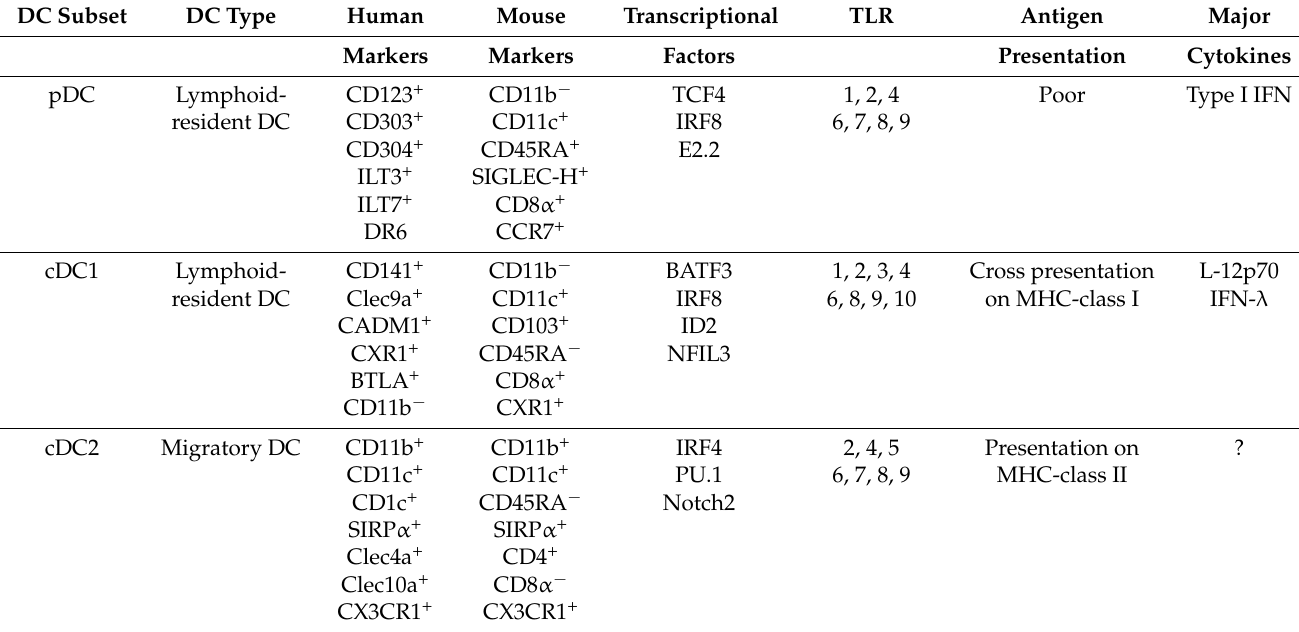
Table 1. Phenotypic markers of dendritic cell